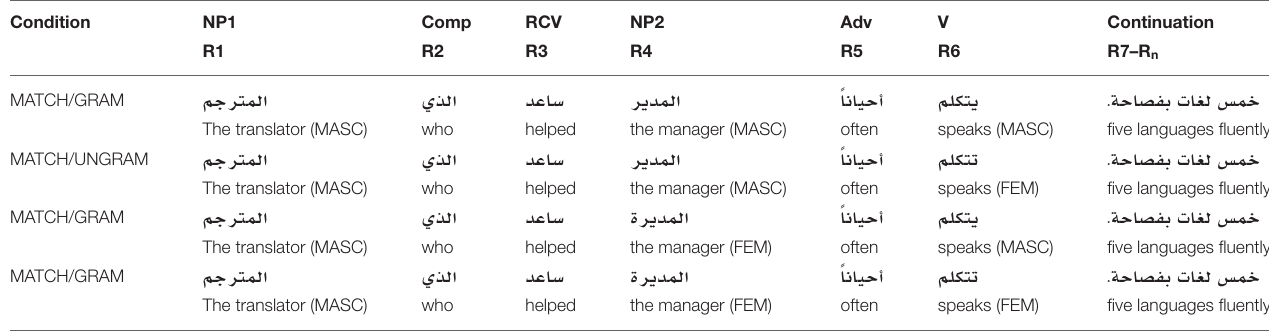
Table 1 | A complete item set for one stimulus in Experiment 1.